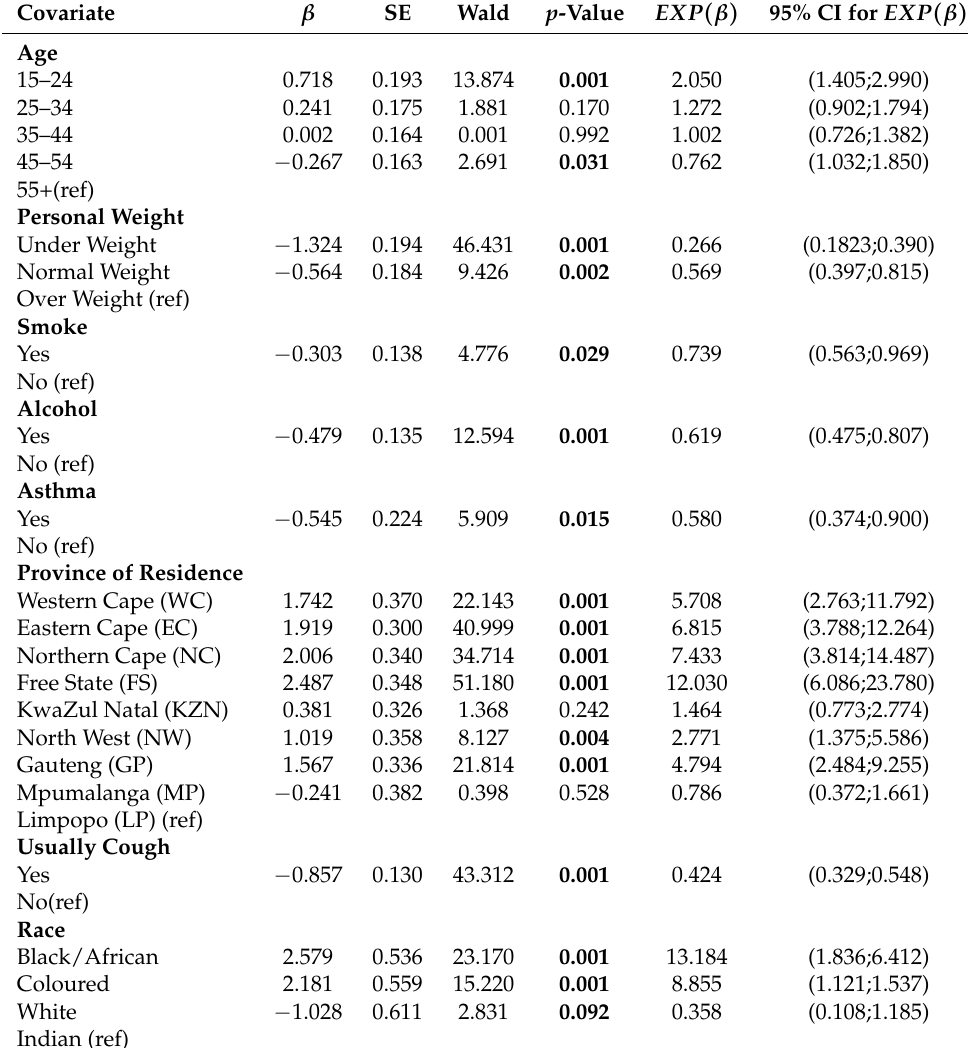
Table 3. Multivariate analysis of factors influencing the development of tuberculosis in South